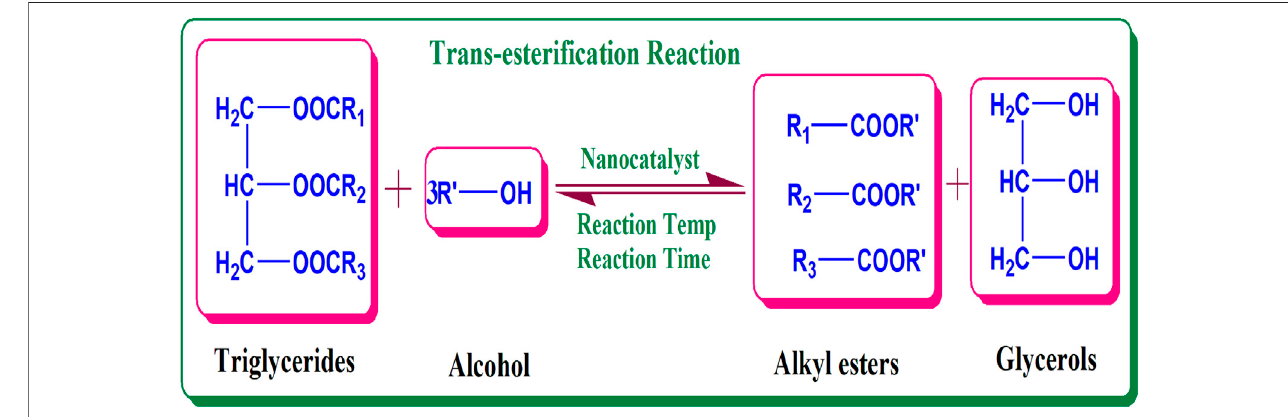
FIGURE 2 | Reaction involved in biodiesel production via trans -esteri fi cation method (Anbessie et al., 2019).